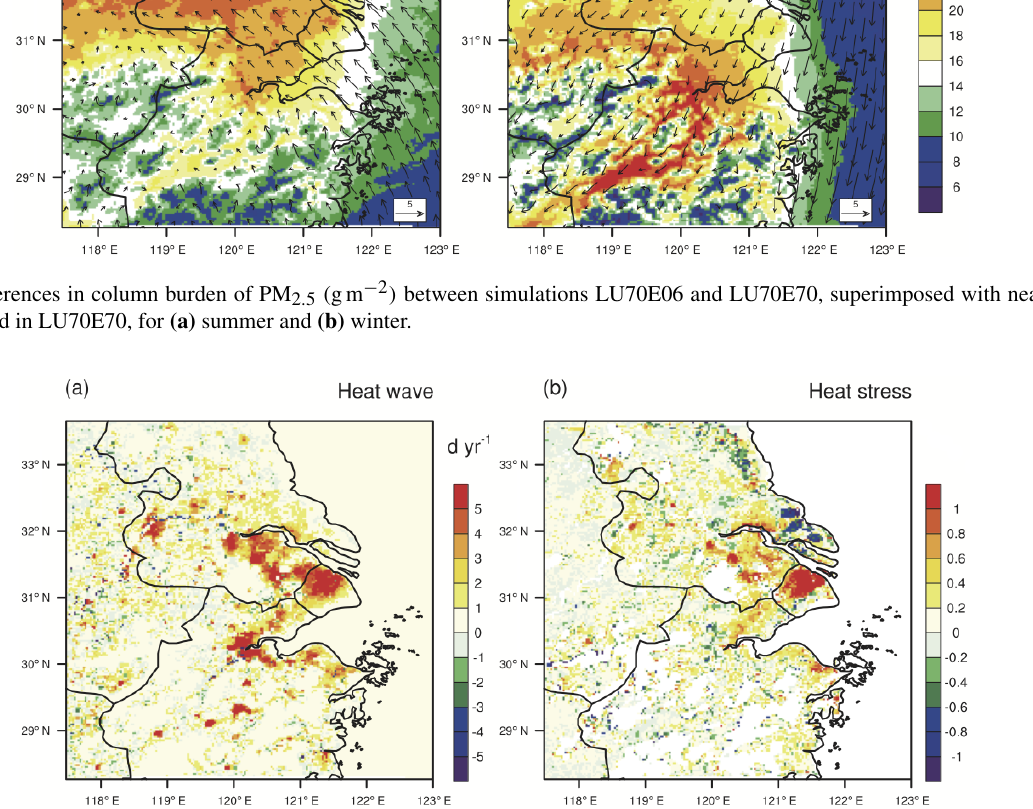
Figure 7. Differences in mean summertime (a) heat wave days (units: dyr − 1 ) and (b) heat stress (units: ◦ C) between simulations LU06E70 and